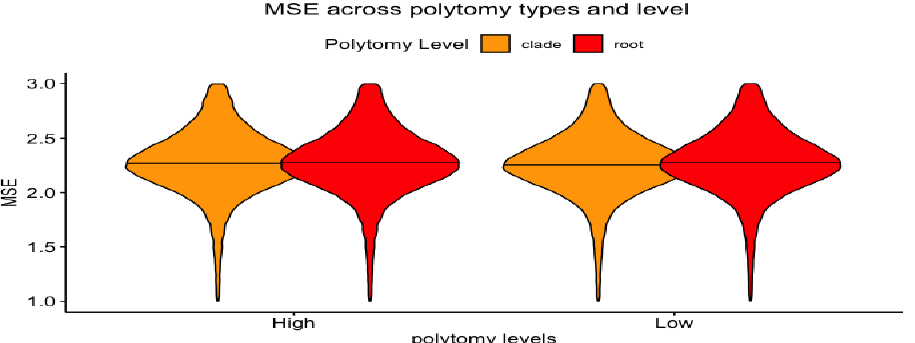
Figure 11. Violin plots of MSE by the polytomy type and level conditioned by taxa size, tree type, and model.